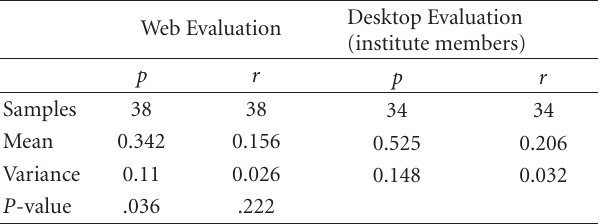
Table 4: Results of the comparison of precision ( p ) and recall ( r ) of the Web-based application and the desktop application using a two- tailed two-sample t -test assuming di ff erent variances, significance level 0.05.